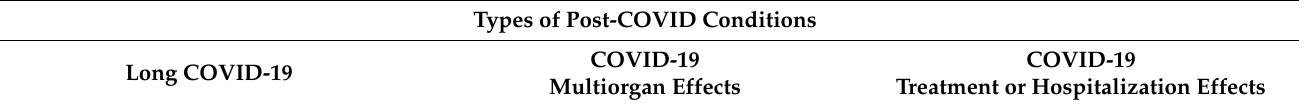
Table 3. Health Issues (post-COVID 19 conditions) for infected individuals according to CDC (modified from